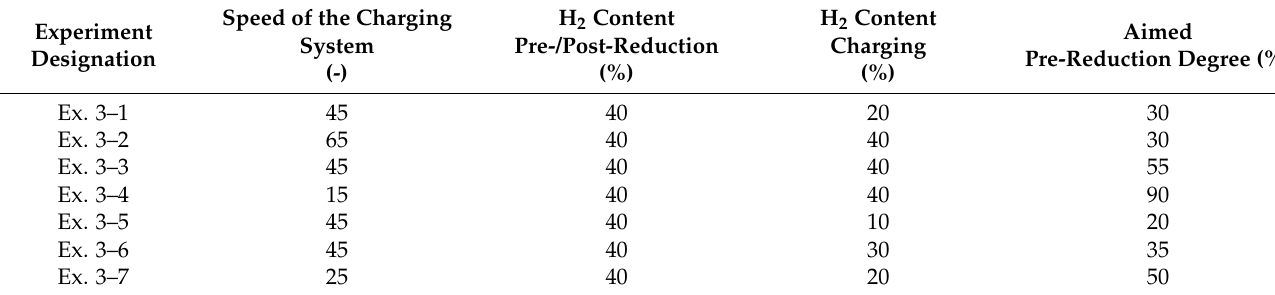
Table 2. Main experimental program.